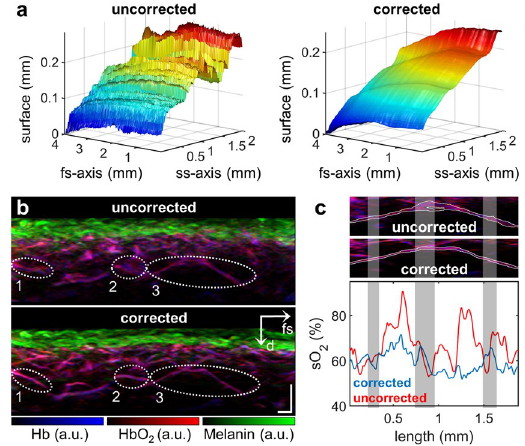
Figure 4. Implementation of the motion correction algorithm in MSOM. (a) Skin surface of healthy lower arm area before and after motion correction. Strong motion artifacts are visible even along the fs-axis because of the long measurement time necessary for multispectral acquisition. Nevertheless, the algorithm is able to generate a smooth, continuous surface. (b) Vertical MAP of unmixed chromophores in the lower arm. Individual vessels enclosed by ellipses 1 and 2 are resolved only after motion correction. The vessel enclosed by ellipse 3 is further analyzed in panel c. (c) Segmentation of the vessel within ellipse 3 in panel b and outlined in white (top and middle panels), followed by measurement of blood oxygenation (oxygen saturation, sO 2 ) across the diameter of the blood vessel within the segmented area (lower panel). The oxygenation level is plotted from left to right along the vessel. Gray bands indicate regions of vessel bifurcation. Scale bar, 250 µ m. Abbreviations: d: depth; fs: